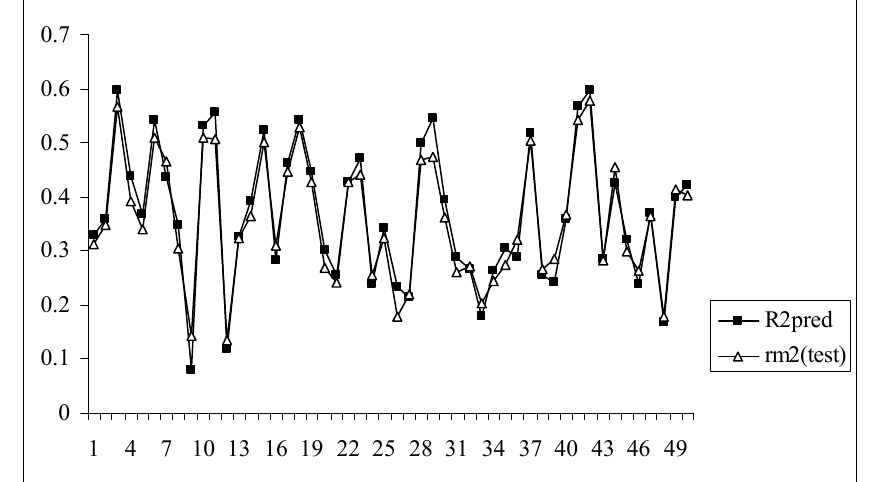
and r m2 values of 50 models (data set pred (test)